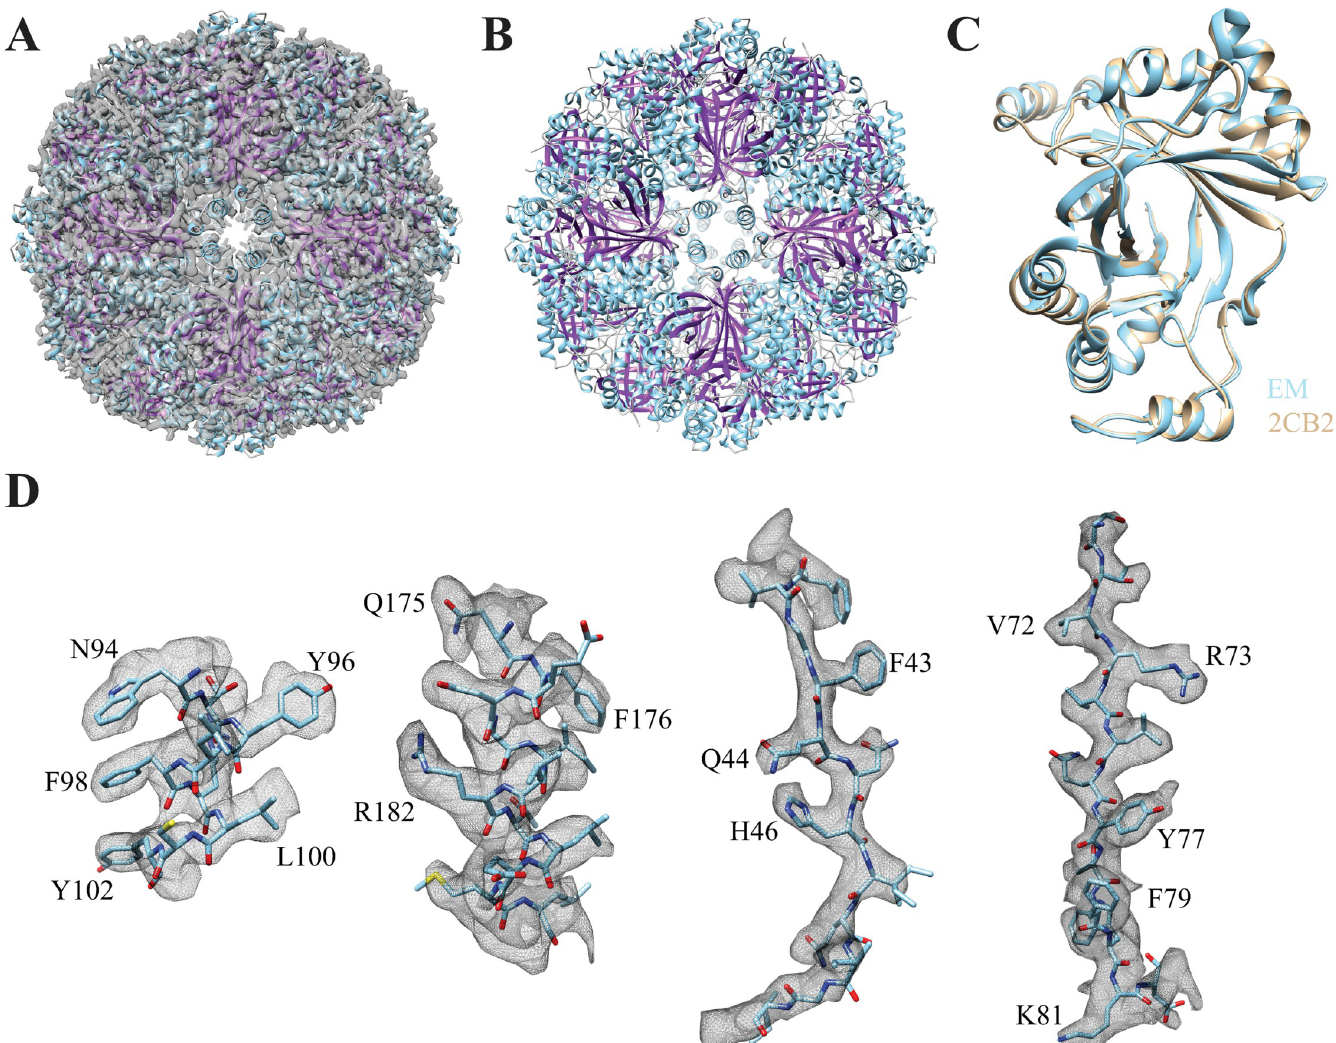
Fig 2. Structural details of SOR. ( A ) The atomic model (7X9W) of the 24 SOR monomers arranged in octahedral symmetry fitted inside the cryo-EM map. ( B ) Ribbon diagram of SOR atomic model. Each of the four identical subunits is viewed from the 4-fold axis. ( C ) The superposition of the atomic model of the monomer based on our cryo-EM map (cyan) onto the x-ray crystal structure (tan, 2CB2). The RMSD between the cryoEM and x-ray crystal structures is 0.575 Å for the 307 C α atoms. ( D ) Representative secondary structural elements of SOR in stick representation fitted inside the respective regions of the cryo-EM map.